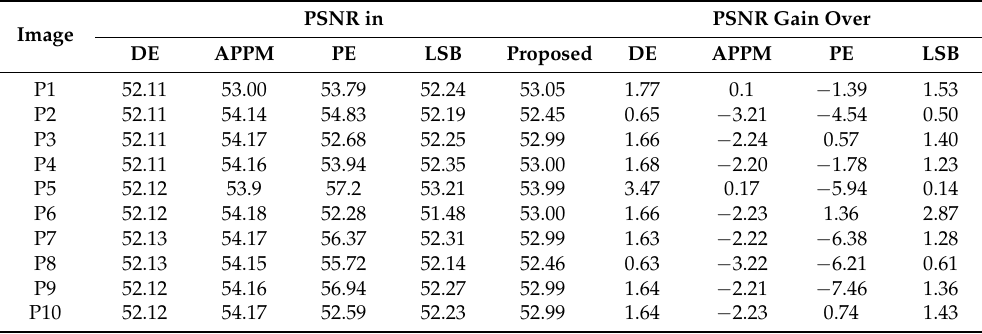
Table 1. Gain of PSNR (peak signal-to-noise ratio) over the